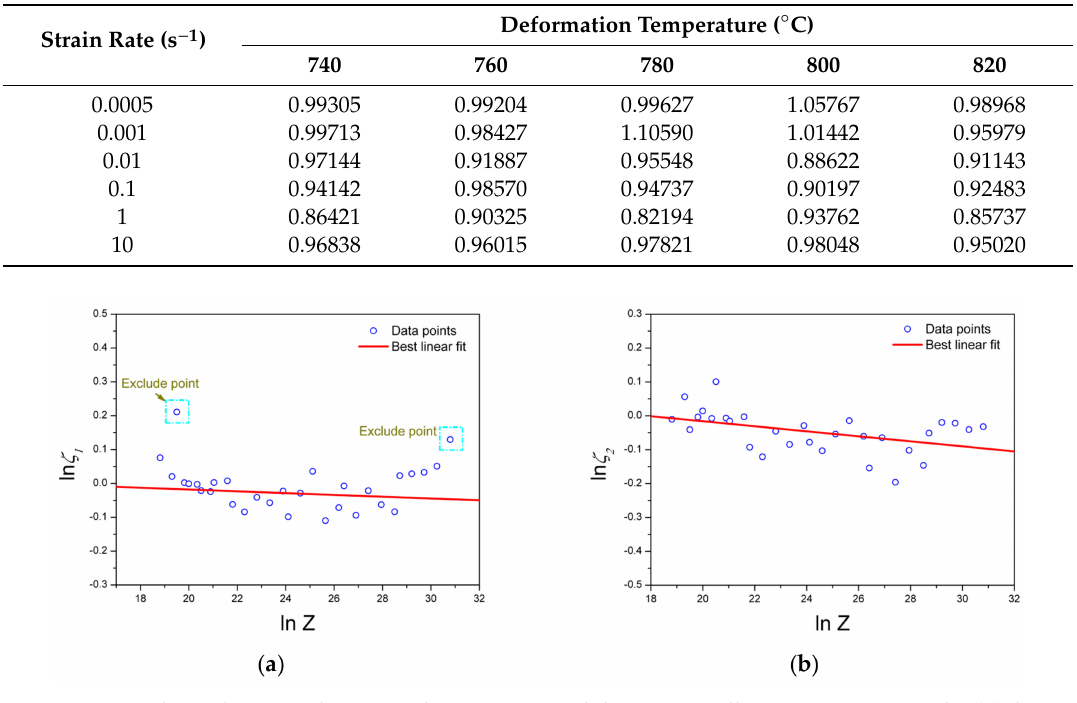
Figure 9. Relation between the material constant, ζ , and the Zener-Hollomon parameter under ( a ) the prior-peak stage; and ( b ) the post-peak